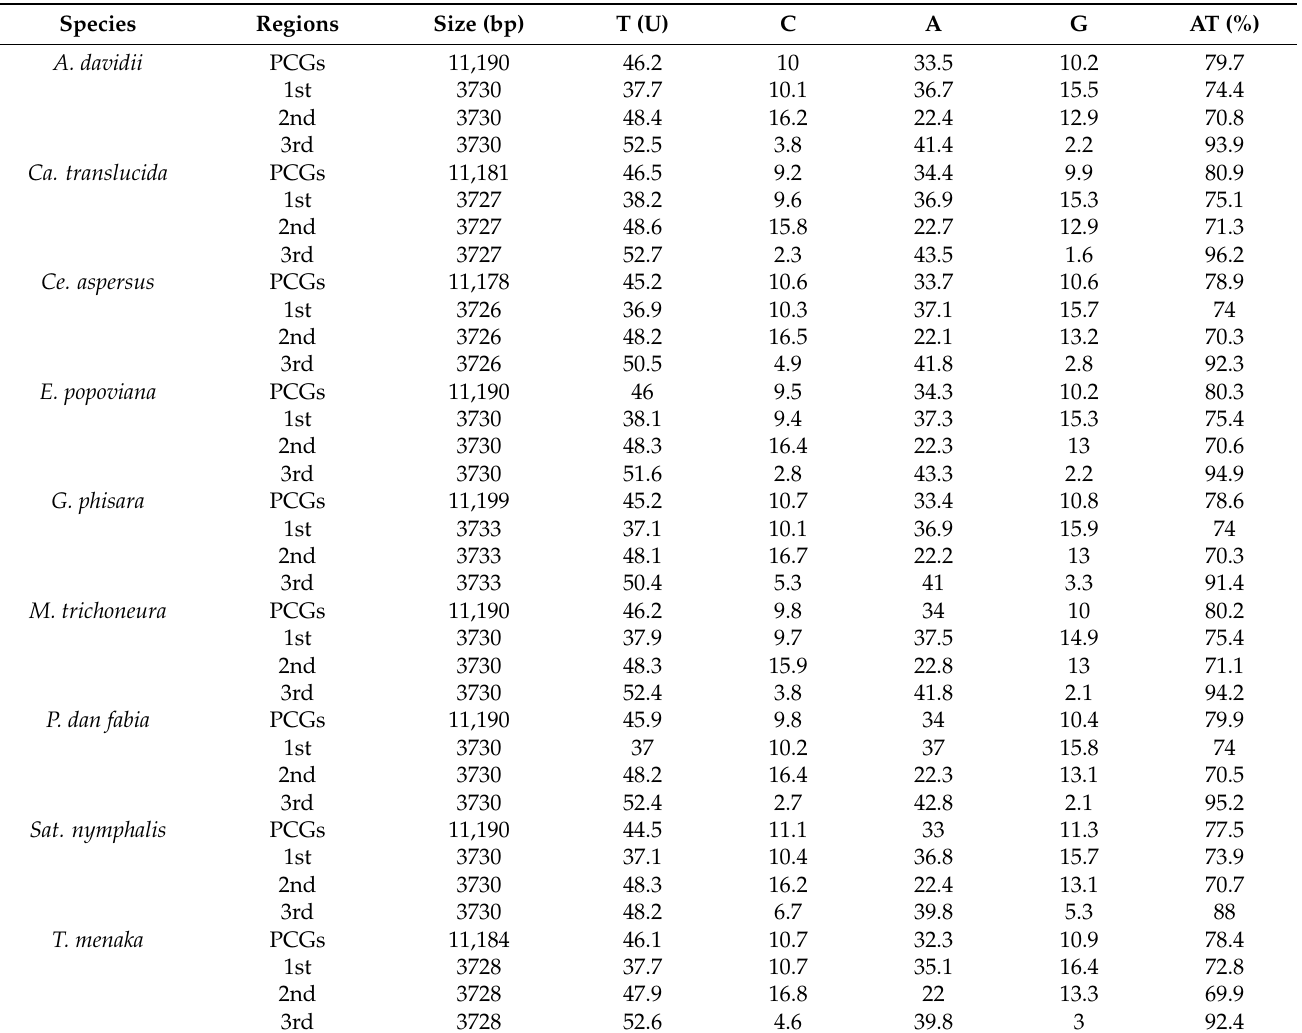
Table 4. Base content of protein-coding